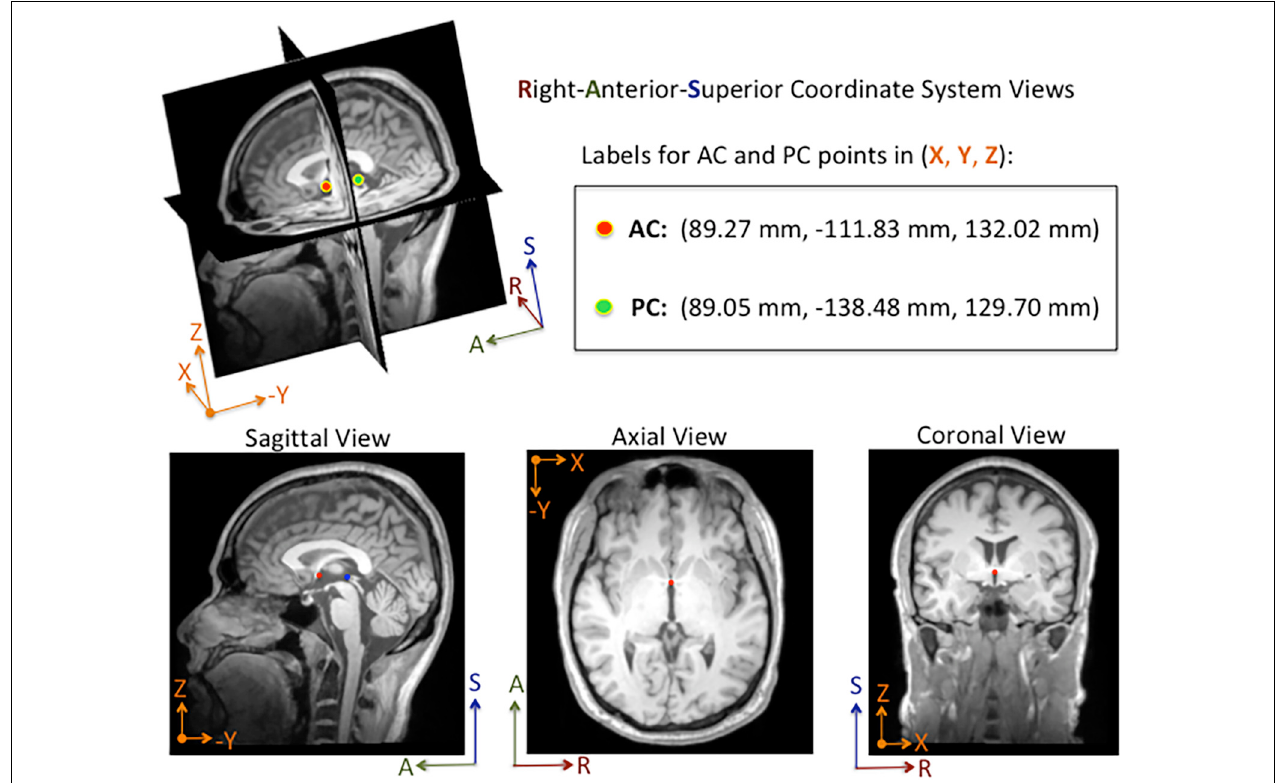
FIGURE 1 | Example of an MRI volume annotated using 3D Slicer software. The volume is displayed in Right-Anterior-Superior (RAS) coordinate space. The annotator manually adjusts fiducial markers overlaid on the AC and PC points from linked 2-D views. For this subject, the AC and PC points are both visible in the same sagittal slice, whereas only the AC point is visible in the axial and coronal slices shown here. Depending on the orientation of the brain within the MRI volume, the AC and PC points are sometimes both visible within a single sagittal and an axial slice. The 3D coordinates for each point are displayed in millimeters in the Cartesian X-Y-Z space. The labels and corresponding 3D coordinates are saved to a fiducial comma-separated values (.fcsv)